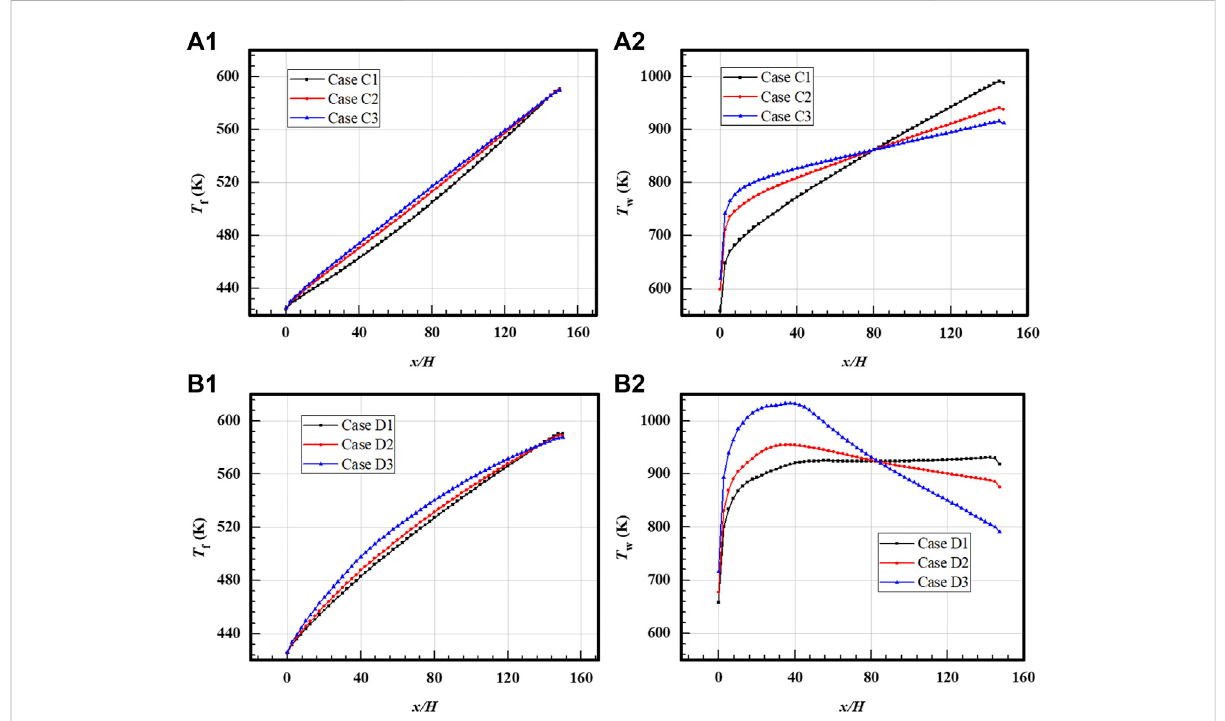
FIGURE 11 Temperature distributions for cases loaded with linear distributions. (A1) Fluid temperature for cases with increased distributions. (A2) Wall temperature for cases with increased distributions. (B1) Fluid temperature for the cases with decreased distributions. (B2) Wall temperature for the cases with decreased